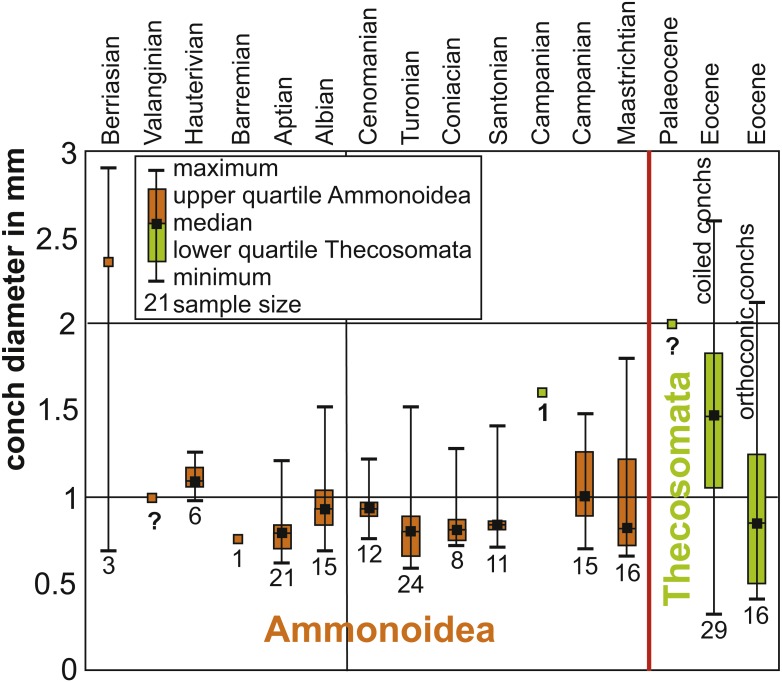
Box plots of Cretaceous ammonitella diameters and Cretaceous to Palaeogene Thecosomata conch size.Data (Table 1) from De Baets, Landman & Tanabe (2015), Laptikhovsky, Nikolaeva & Rogov (2017), Lokho & Kumar (2008), Janssen, Schnetler & Heilmann-Clausen (2007), Janssen, Sessa & Thomas (2016), Janssen & Goedert (2016), and Janssen & Peijnenburg (2017). The red line marks the Cretaceous-Palaeogene boundary. The numbers below the box plots give the sample size. Orange marks ammonitella data, while green marks gastropod data. Question marks indicate that fossils are present but the values indicate guesses: in the case of Valanginian ammonites, protoconchs are known and from that size, an ammonitella size close to 1 mm appears likely. In the case of Campanian and late Palaeocene Thecosomata, the only genus ranging back into the Campanian is Heliconoides (Janssen & Goedert, 2016; Janssen & Peijnenburg, 2017); Eocene specimens measure approximately 2 mm, hence this size estimate.